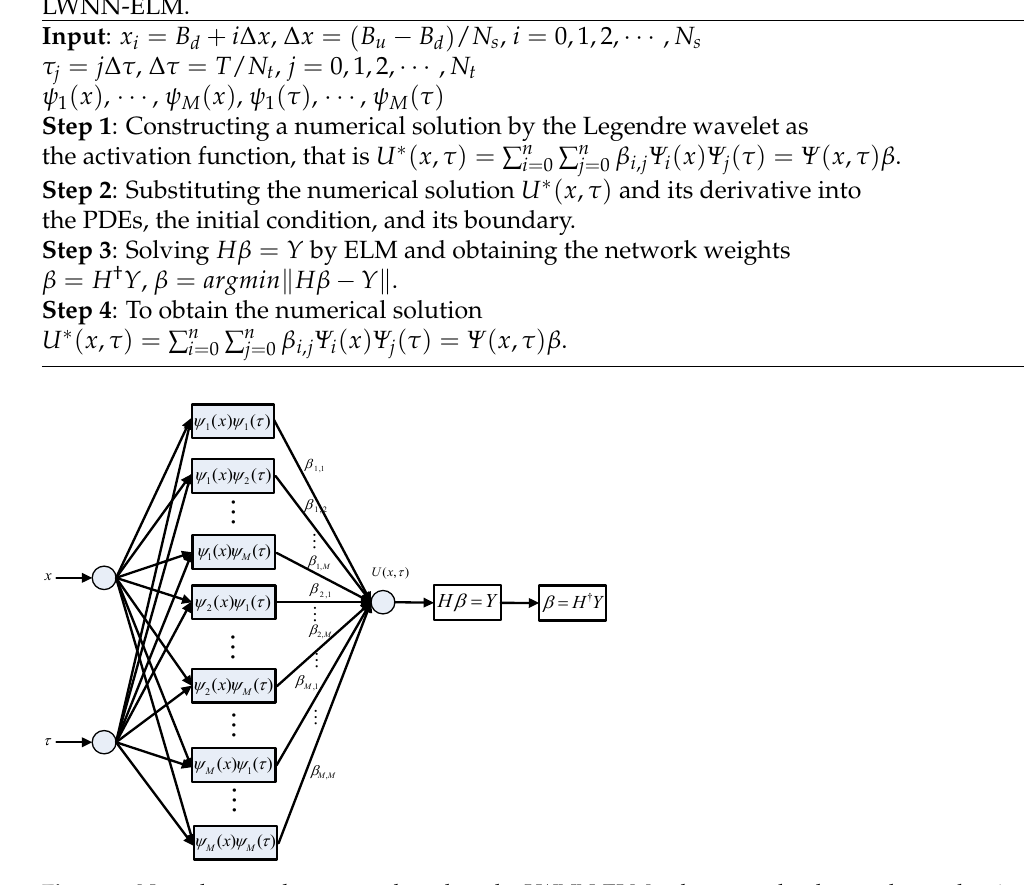
Figure 1. Neural network structure based on the LWNN-ELM, where x and τ denote the stock price and time,